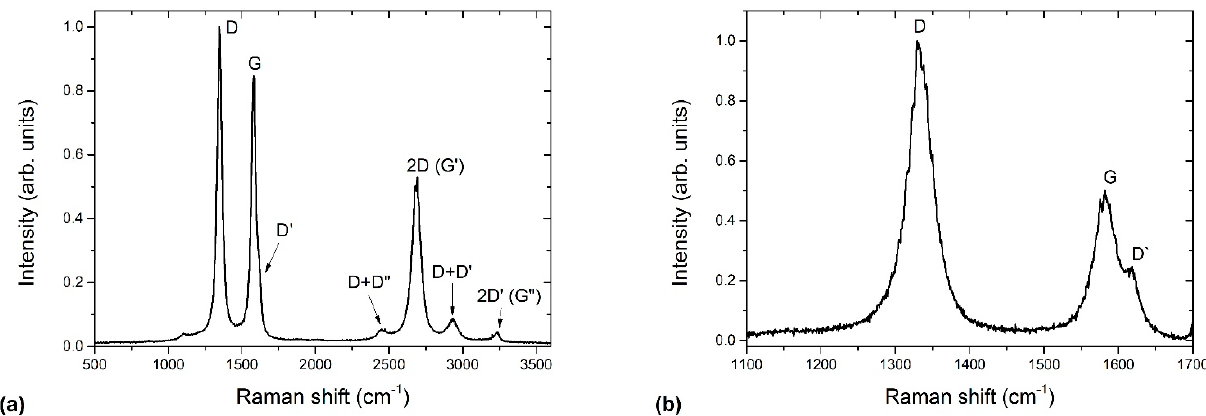
Figure 13. ( a ) Comparison of Raman spectra of N-doped carbon nanomesh samples, ( b ) a detail showing a D’ band.